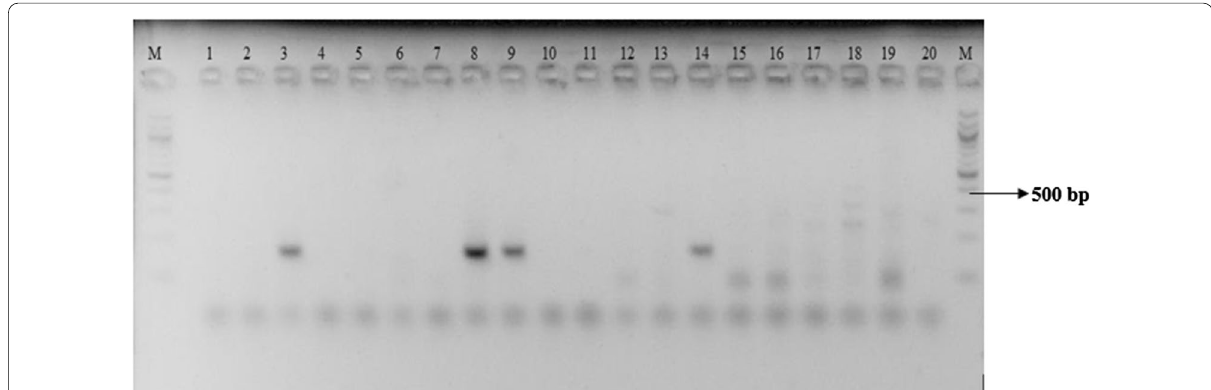
Fig. 1 Amplification profile of mosquito species with primers from the IGS gene region. M